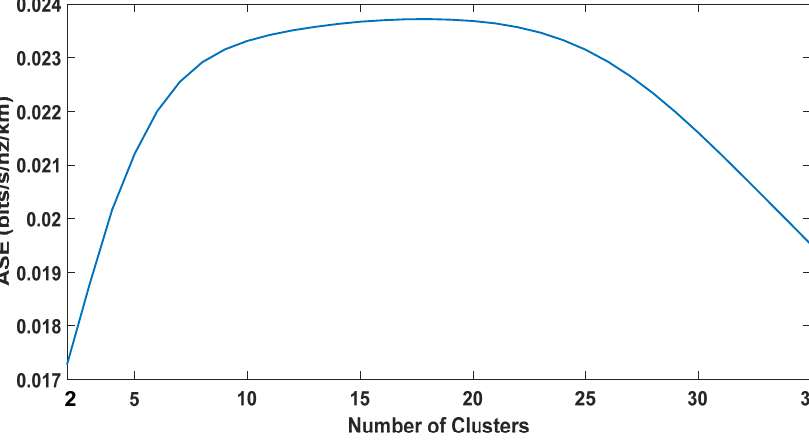
Figure 15. ASE and the number of clusters: a comparison.